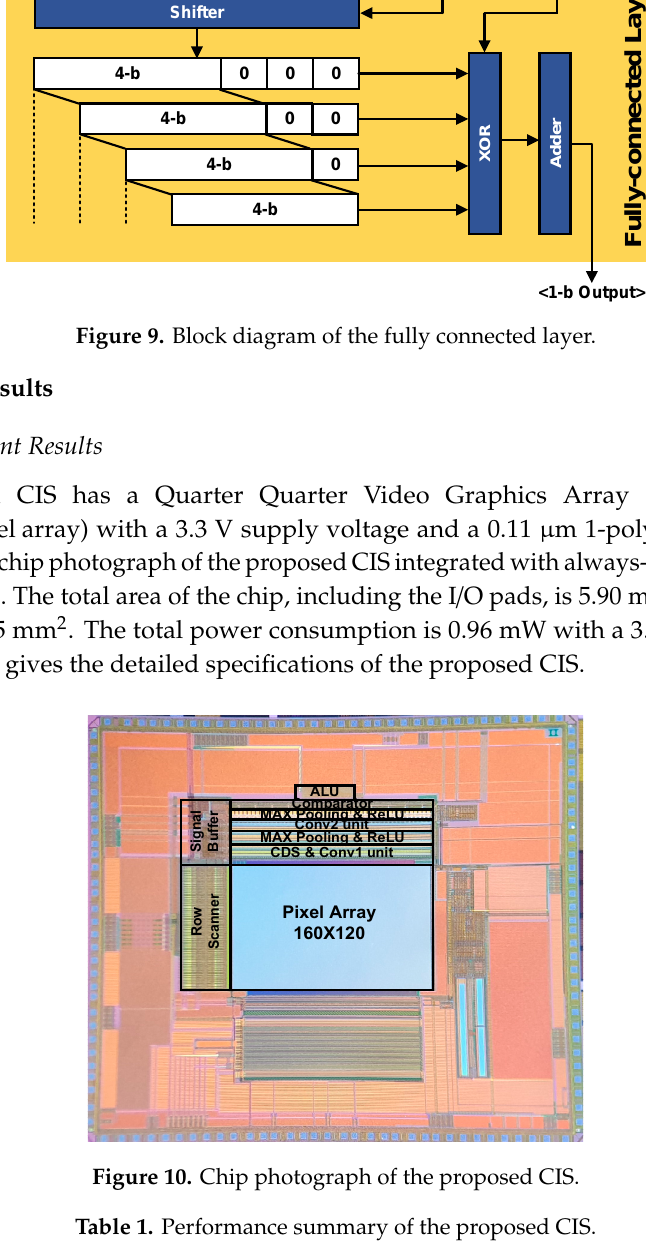
V in5 Figure 7. The voltage-mode MAX circuit. vo l t a g e ( V ) time (μs) 0.5 Figure 8. Simulation results of the voltage-mode MAX circuit. After analog convolution processing in the analog domain, data were reduced from 160 to 10 columns. As mentioned earlier, image data size (160 × 120) can be reduced by one quarter for each layer, finally resulting in 10 × 8 (two convolution units and two pooling units with a 2 × 2 filter and stride, as shown in Figure 4). The column data were converted to the digital domain with the 4-bit single-slope ADC. For the FC operation, a 4-bit fixed-point number and 5-bit floating-point number